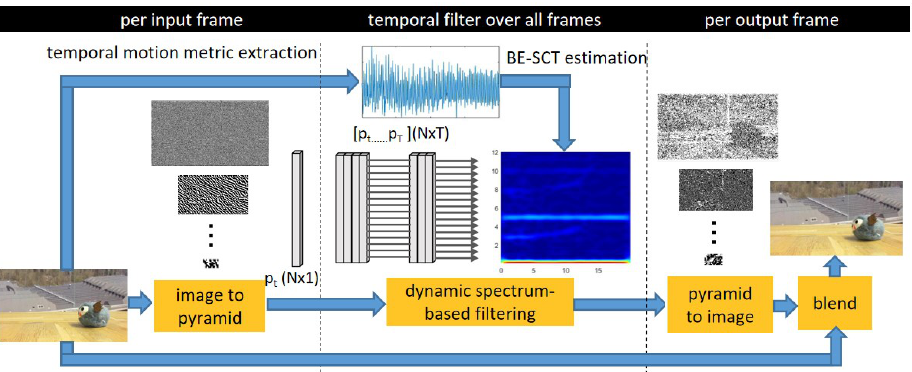
Figure 3. Video spectrum-aware magnification pipeline. Our approach does not require manual region annotation nor additional depth information as done in conventional techniques; instead, by employing the proposed BE-SCT, the intrinsic frequency characteristics can be understood to achieve the goal of adaptive large motions isolation, meanwhile avoiding the nonlinear limitation in the Eulerian acceleration